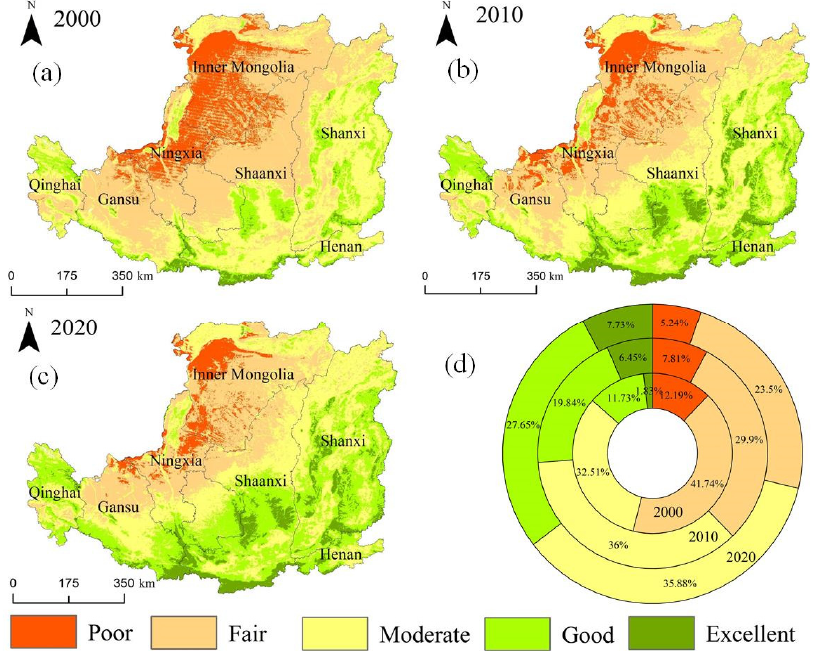
Figure 4. Spatiotemporal changes of RSEI in the Loess Plateau during 2000 ( a ), 2010 ( b ) and 2020 ( c ) and the ratio of each RSEI class from 2000–2020 ( d ).